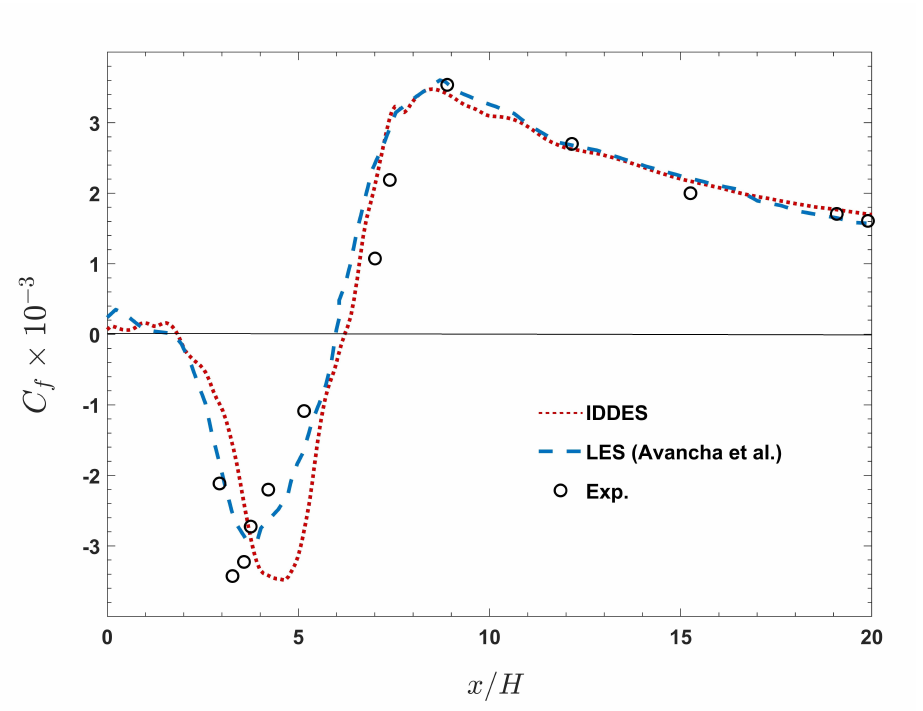
Figure 8. The distribution of the mean skin friction for the isothermal wall case.